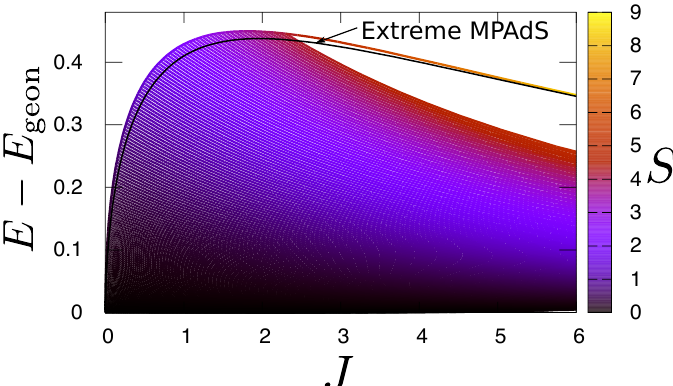
Figure 3 . Entropy of black resonators as a function of ( E − E geon , J ) . The upper solid curve indicates the onset of the gravitational superradiant instability of the MPAdS, where the black resonators branch off. The extreme MPAdS is shown by a black curve. In the upper-right region below the onset curve, we simply do not have numerical